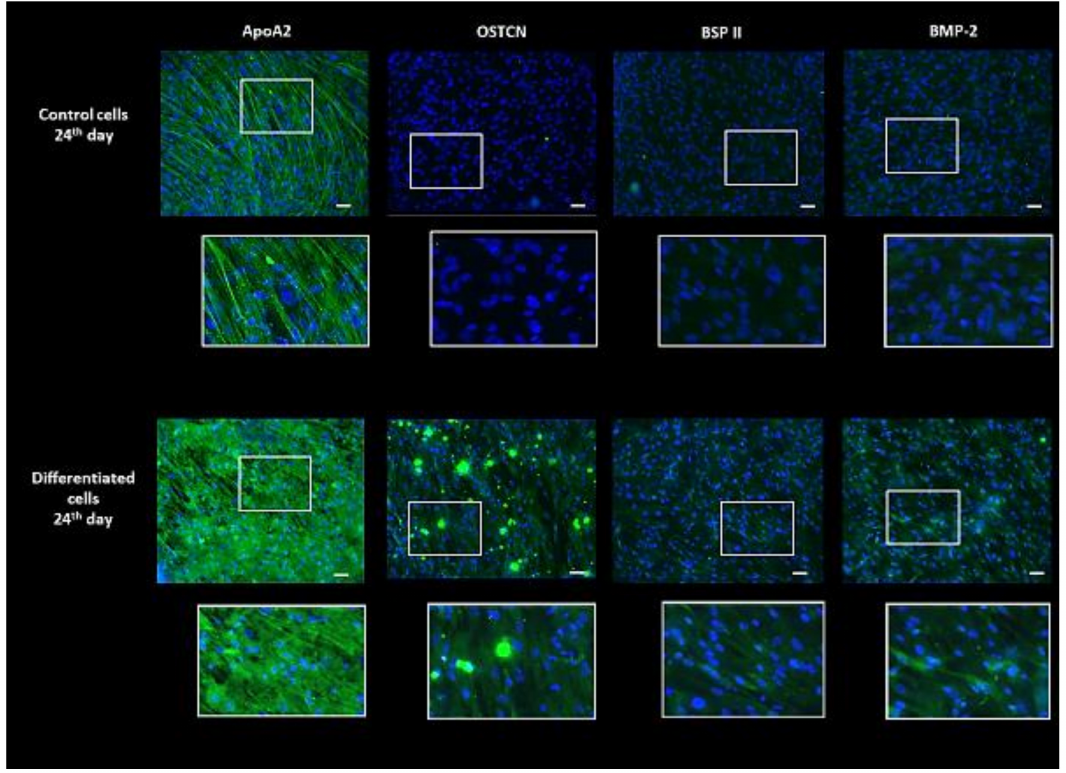
Figure 3. Content of osteogenic markers and apolipoprotein A2. Cells were fixed with 4% paraformaldehyde. Specific proteins apolipoprotein A2 (ApoA2), osteocalcin (OSTCN), bone sialoprotein (BSP II), and bone morphogenetic protein (BMP-2) were detected by immunocytochemistry using WiScan microscope. Nuclei were visualized by DAPI stain. Bar = 50 µ m. Areas with white rectangles are shown as magnified insets below each